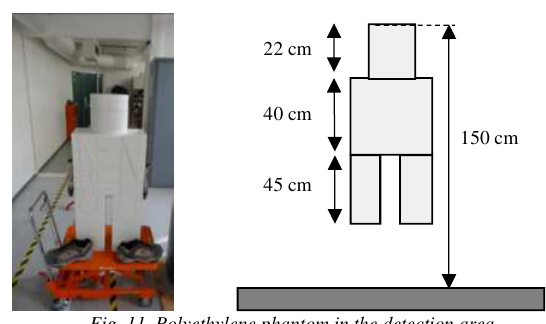
Fig. 11. Polyethylene phantom in the detection area.